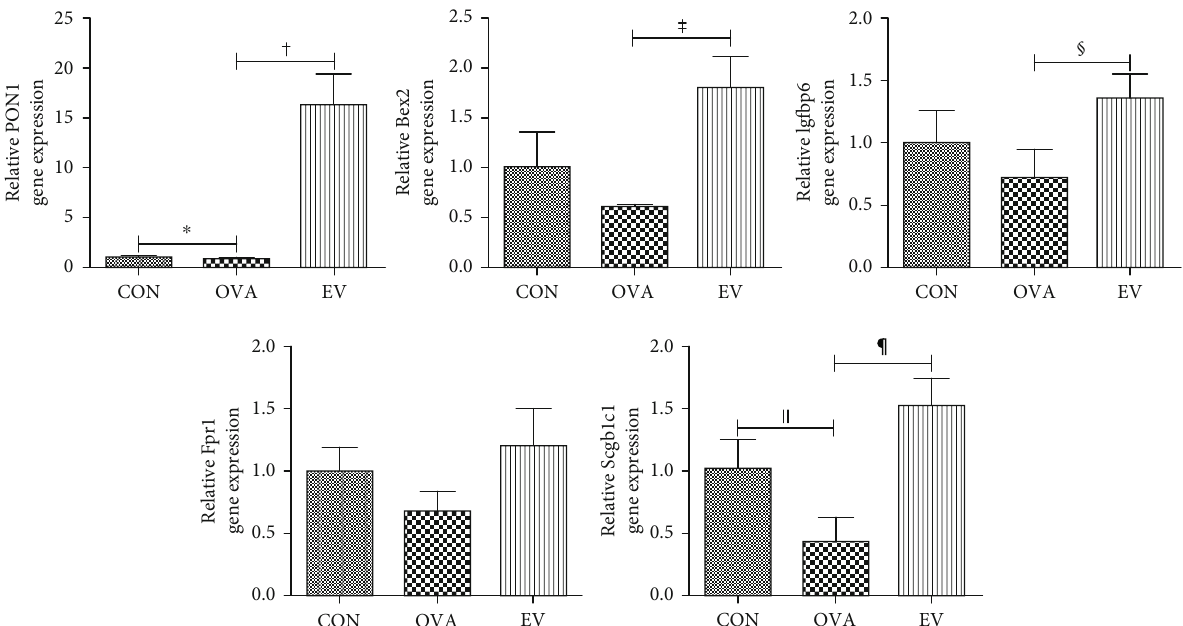
Figure 4: E ff ects of ASC-derived EVs on PON1, Bex2, Igfbp6, Fpr1, and Scgb1c1 gene expression. PON1 and Scgb1c1 gene expression was signi fi cantly decreased in the OVA group compared to the CON group. However, EV treatment markedly increased the expression of PON1, Bex2, Igfbp6, and Scgb1c1 in asthmatic mice. † p = 0 : 001 ; ‡ p = 0 : 003 ; § p = 0 : 022 ; ‖ p = 0 : 008 ; ¶ p < 0 : 001 . ASCs: adipose stem cells; Bex2: brain- expressed X-linked 2; CON: control; EV: extracellular vesicle; Fpr1: formyl peptide receptor 1; Igfbp6: insulin-like growth factor binding protein 6; OVA: ovalbumin; PON1: paraoxonase 1; Scgb1c1: secretoglobin family 1C member